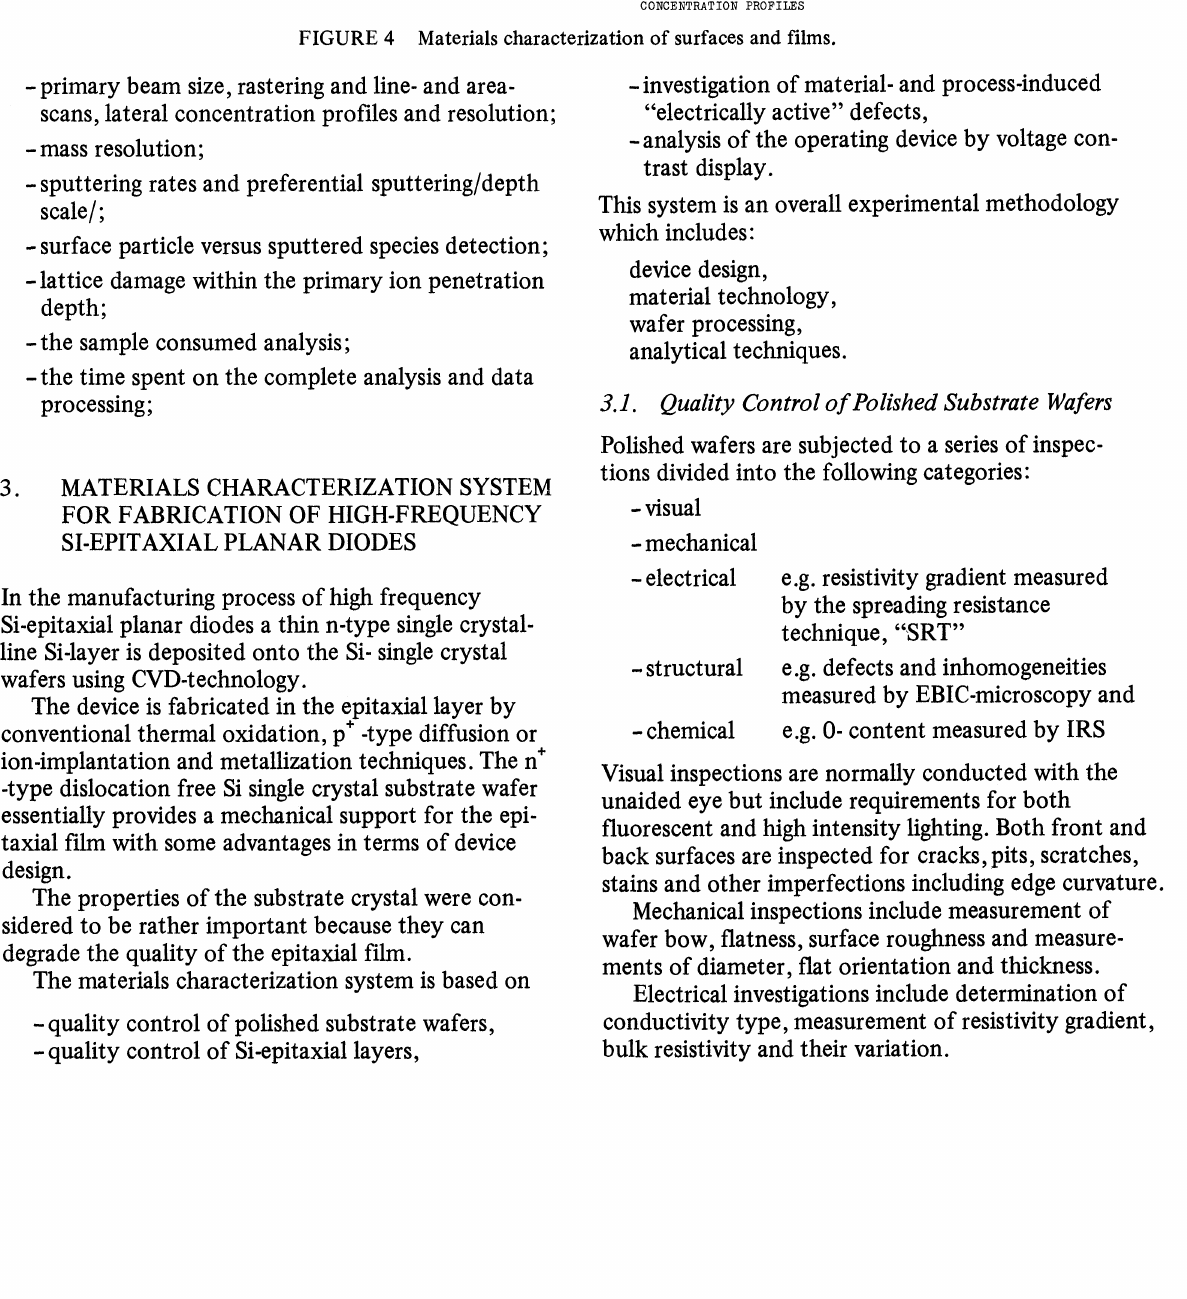
FIGURE 4 Materials characterization of surfaces and